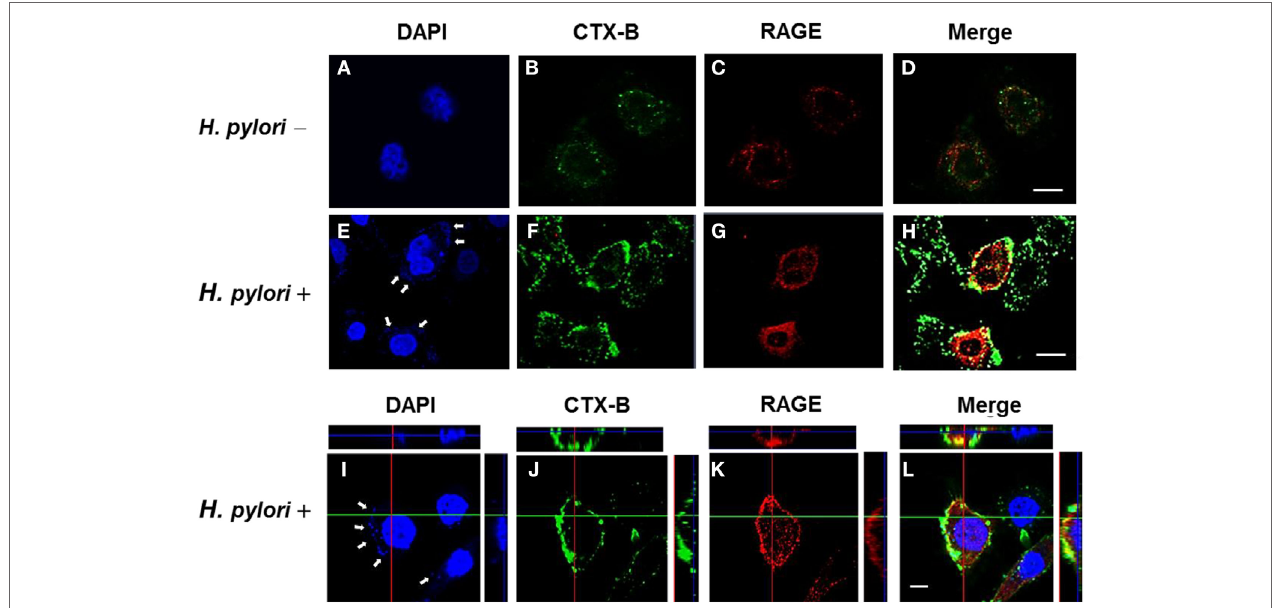
FigUre 6 | Mobilization of rage into lipid rafts at sites of H. pylori infection . AGS cells were uninfected or infected with H. pylori (MOI = 100) for 6 h. Cells were fixed and stained with DAPI (blue) (a,e,i) to visualize H. pylori (arrows) and cell nuclei, with Alexa Fluor 488-conjugated cholera toxin subunit B (CTX-B) to visualize GM1 (green) (B,F,J) , or with antibody against RAGE (red) (c,g,K) , and then the merged images were observed by confocal microscopy (D,h,l) . Merged confocal z -section images (i–l) show bacteria colocalized with RAGE and CTX-B (cyan). Bars, 10 μ m.